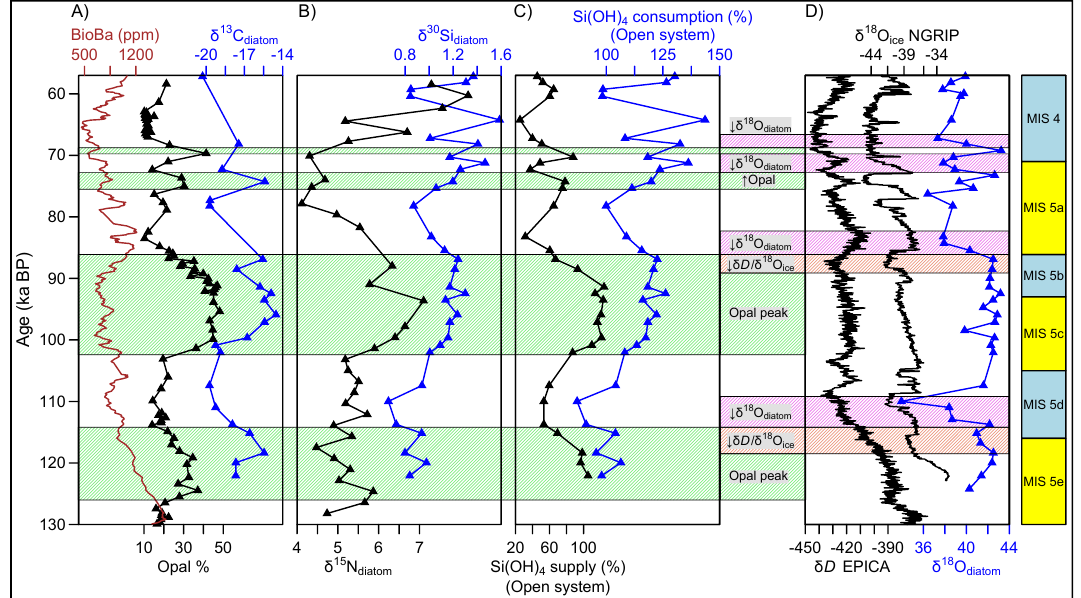
Figure 3. Data from ODP Site 882 showing changes in (a) productivity ( δ 13 C diatom , BioBa; Jaccard et al., 2005, and opal concentrations; Jaccard et al., 2009); (b) nutrient dynamics ( δ 30 Si diatom and δ 15 N diatom ; Brunelle et al., 2010); (c) modelled Si ( OH ) 4 supply/consumption in an open system model; and (d) freshwater input ( δ 18 O diatom ) together with EPICA Antarctic δ D (Jouzel et al., 2007) and NGRIP Greenland δ 18 O ice (NGRIP, 2004). Changes in the supply/consumption of Si ( OH ) 4 are relative to mean conditions in MIS 5e. Green/red shading indicates the increases in productivity and decreases in δ 18 O diatom respectively, which are discussed in the